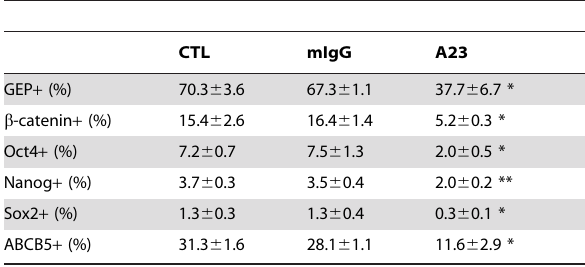
Table 2. GEP blockage by anti-GEP antibodies suppresses the expression of ES cell-related signaling molecules and